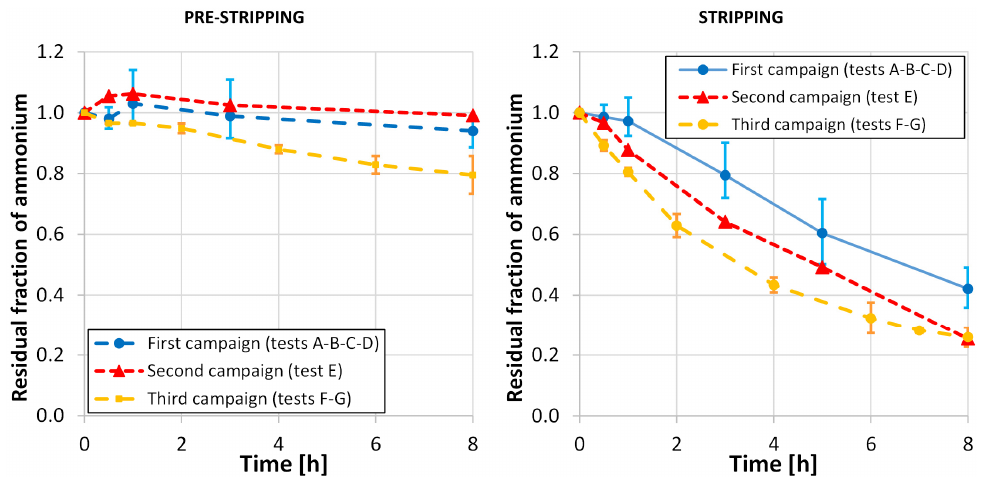
Figure 4. Trend of the residual fraction of ammonium during the stripping process. Baffles show the variation among tests of the same campaign.